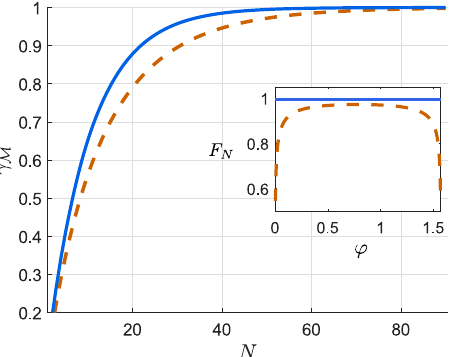
Fig.9|ConvergencetotheperfectQFIwiththephoton-number N fordifferent noisy photodetection channels. γ M (cid:6) N for different dark-count rates, p , given a fi nitedetectionef fi ciency(losses) η =0.1.Theblue(solid)linecorrespondstolosses without dark counts p =0, while the orange dashed line also includes a dark-count rateof p =0 : 01. Inset: TheFIasafunctionof theangle φ between ∣ N ,0 i and ∣ 0, N i in Eq. (46) that parametrises the global control unitary V ~ Φ . While with only losses (solid blue line)any angleisoptimal,darkcounts (dashed orange line) remove this symmetry. In this illustration, N